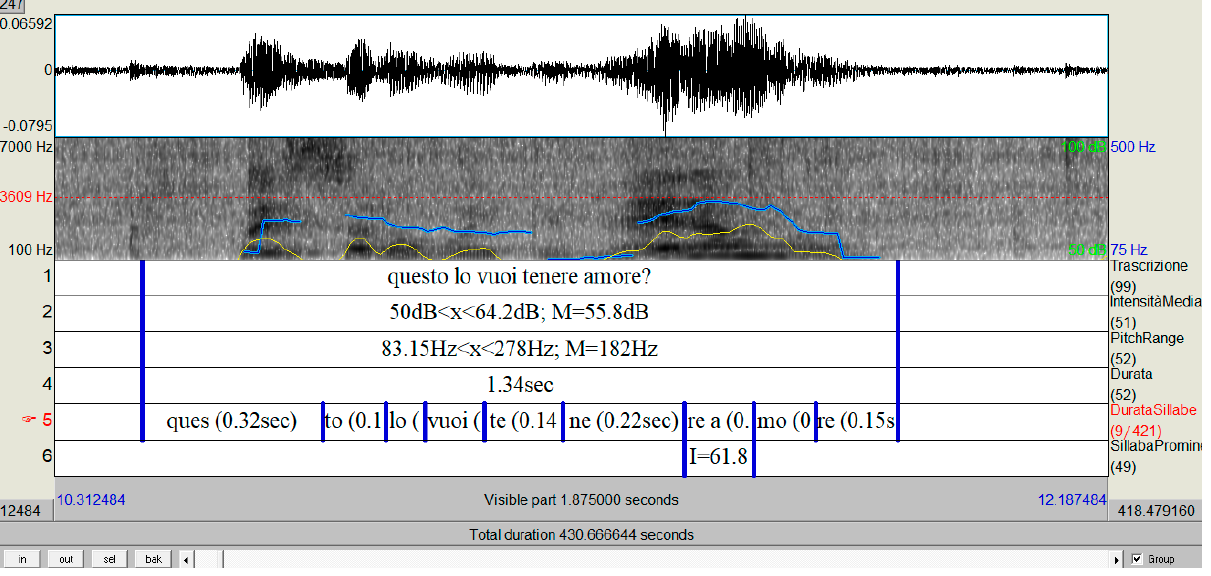
Figure 2. Oscillogram, sonogram, and spectrogram of the statement in which the intensity curve (in yellow) and that of the fundamental frequency (in blue) are visible; below is a series of TextGrids used for labeling.